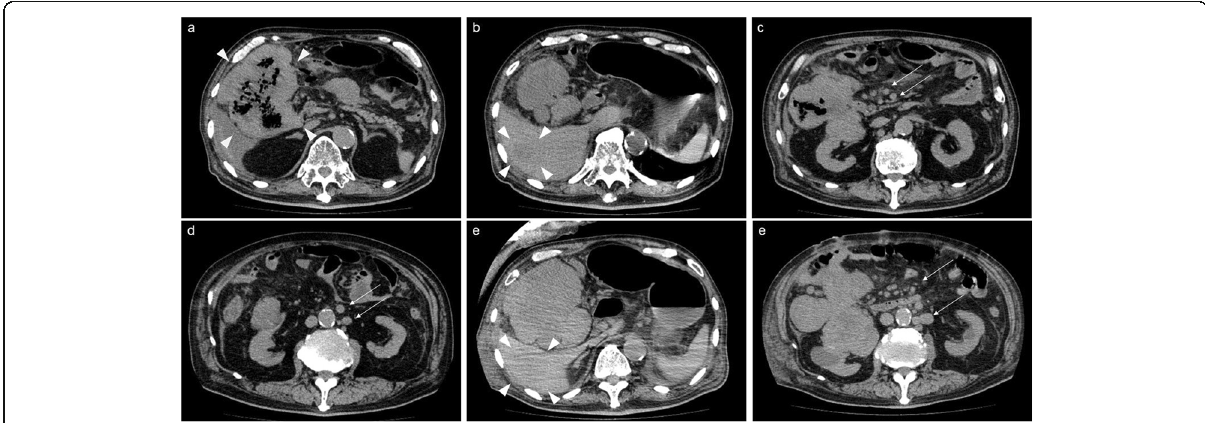
Fig. 1 Computed tomography scan. Computed tomography shows a large intra-abdominal mass infiltrating into the colon and retroperitoneum ( a , arrowhead) as well as the low-density area of the liver ( b , arrowhead), peritoneal nodule ( c , arrow), and lymphadenopathy in several paraaortic lymph nodes, suggesting metastases or dissemination ( d , arrow). Pneumoperitoneum was visible, suggesting colon perforation near the tumor. Liver tumor, metastatic lymph node, and peritoneal dissemination were enlarged after 1 month ( e , f , arrow,